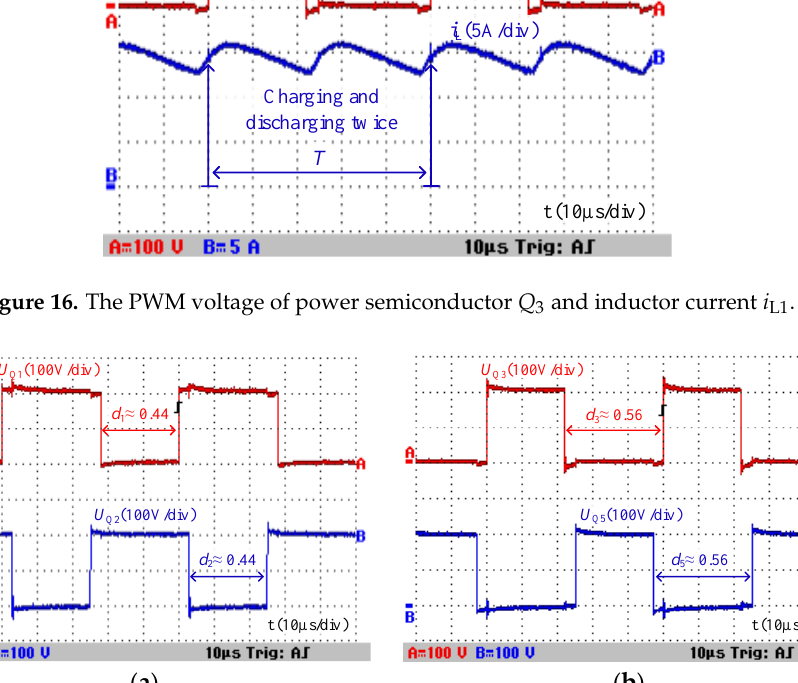
Figure 17. The PWM voltages of power semiconductors; ( a ) U Q1 and U Q2 ; ( b ) U Q3 and U Q5 .